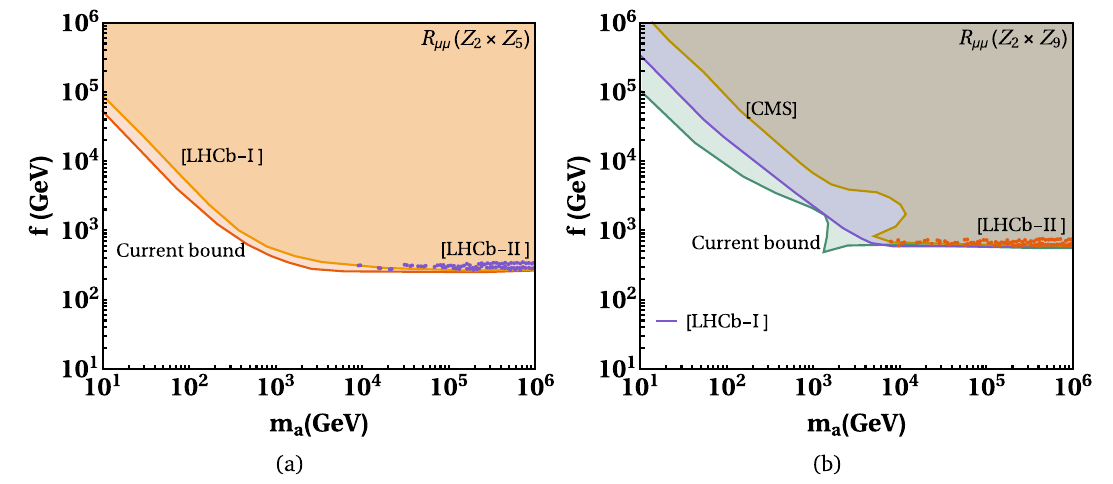
Fig. 8 The left panel represents the allowed parameter space by R μμ fortheminimal ( Z 2 × Z 5 ) modelwith λ χ = 2withthecurrentmeasure- ment and for the future projected sensitivity of the LHCb Phase-I and